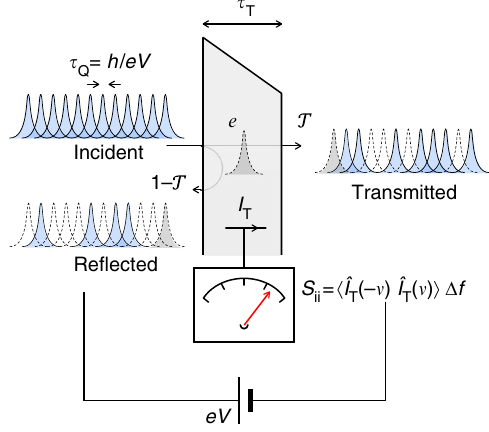
Fig. 1 Tunnel barrier connected to a constant voltage source. According to the wave-packet picture, the voltage source acts as a regular single electron source with the average time between electrons emitted per channel per spin from the macroscopic contact is τ Q = h / e | V |. The electrons can